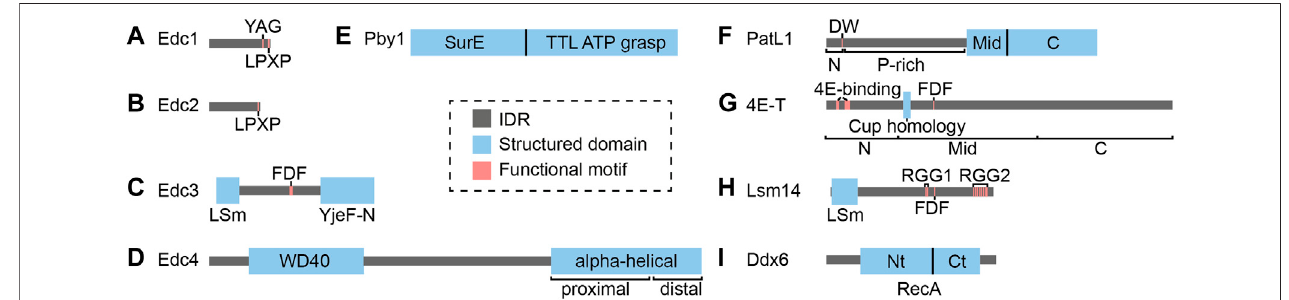
FIGURE 2 | Domain organization of various decapping activators. The archetypal domain organization of (A) Edc1, (B) Edc2, (C) Edc3, (D) Edc4, (E) Pby1, (F) PatL1, (G) 4E-T, (H) Lsm14 and (I) Ddx6 are illustrated. Depicted are the S. cerevisiae orthologs of Edc1, Edc2 and Pby1, and the H. sapiens orthologs of the other decapping activators. Conserved domains and motifs are highlighted, and species-speci fi c features are discussed in the main text. Abbreviation: IDR = Intrinsically Disordered